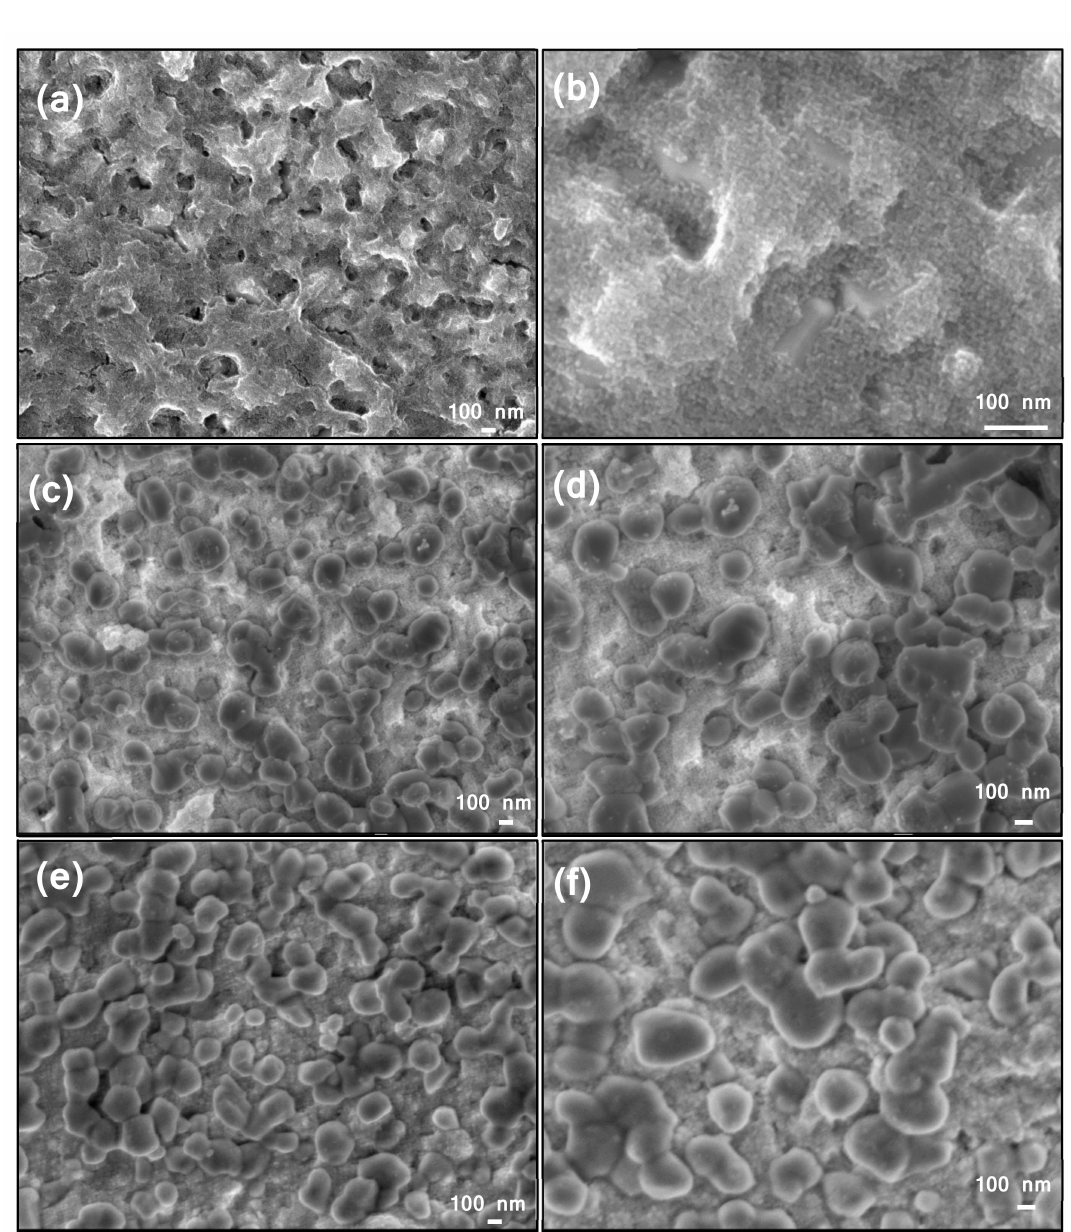
a SnO 2 bu ff er layer on FTO substrates. ( e , f ) FE-SEM images of NiWO 4 nanoparticles over BiVO 4 / SnO